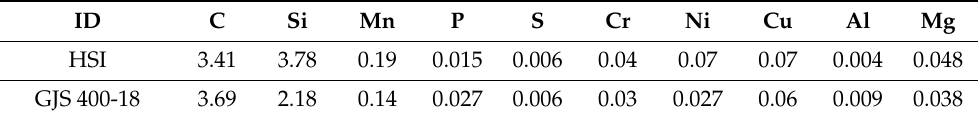
Table 1. Compositions subjected to R = 0.1 and 20 Hz loading in push–pull [5].